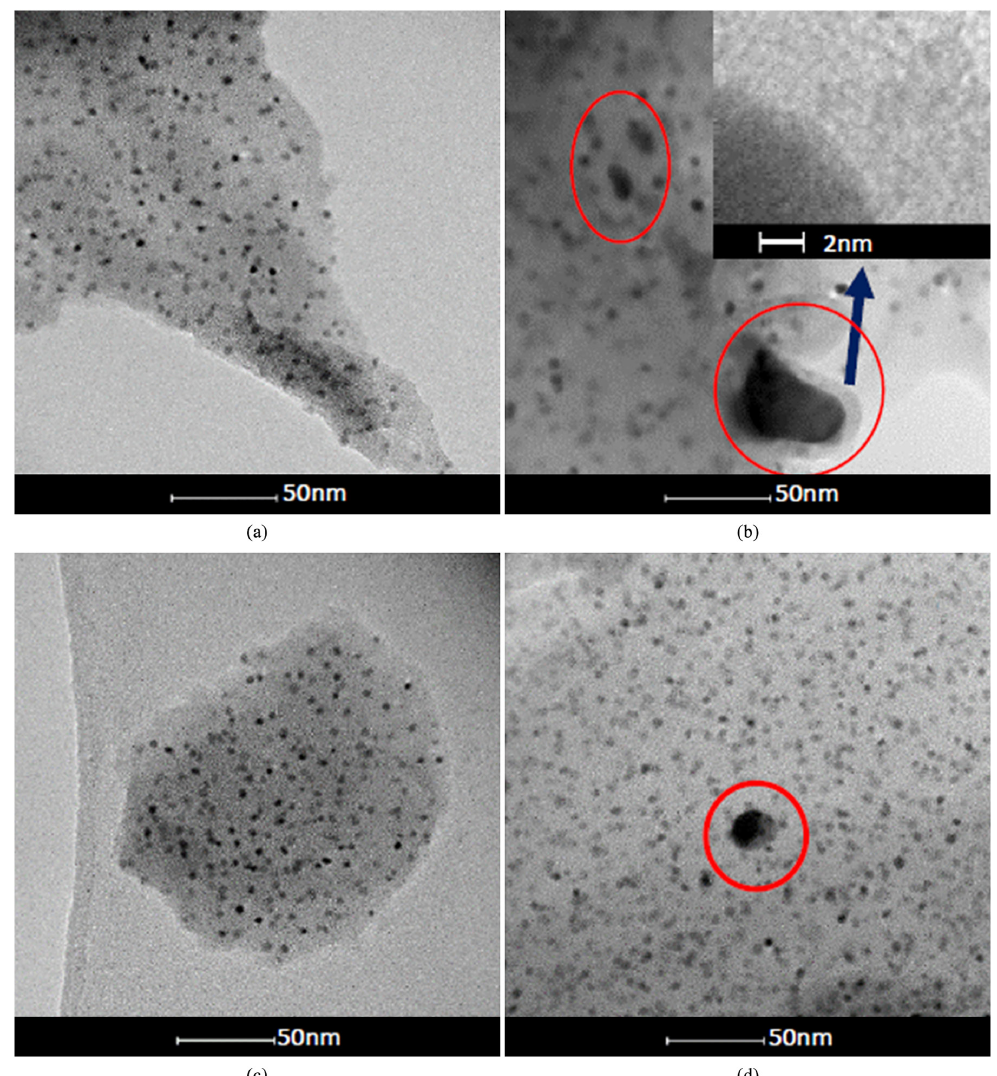
Figure 5. TEM micrographs of (a) Ni-C500; (b) Ni-C600; (c) and (d) Ni-C700